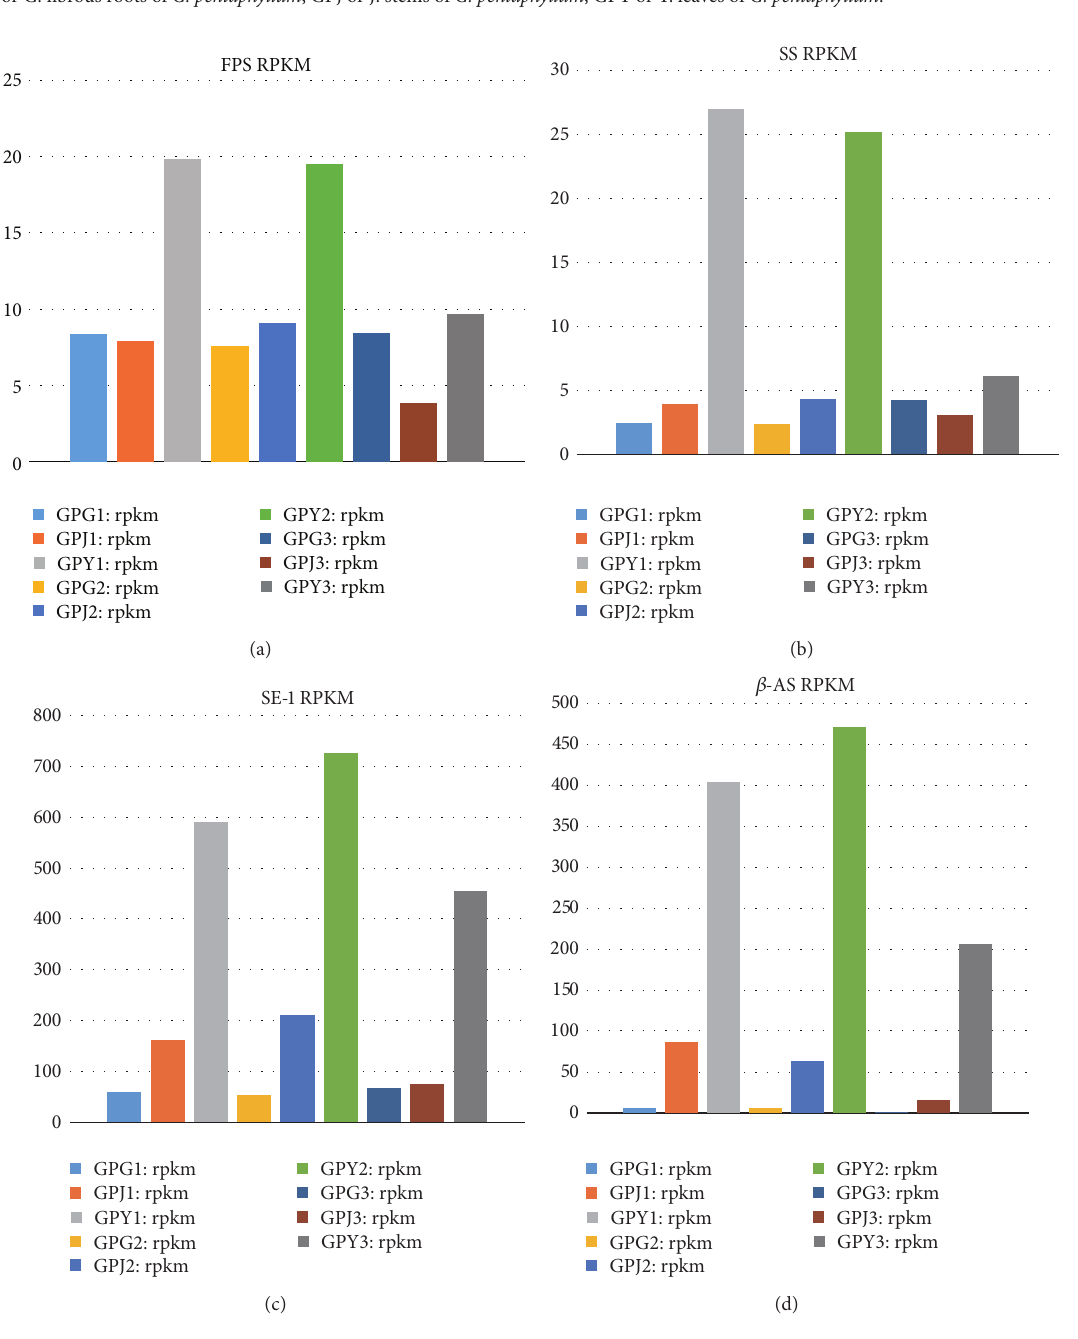
Figure 5: RPKM of FPS, SS, SE, and 𝛽 -AS. Note: (a) RPKM of FPS; (b) RPKM of SS; (c) RPKM of SE-1; (d) RPKM of 𝛽 -AS; GPG: